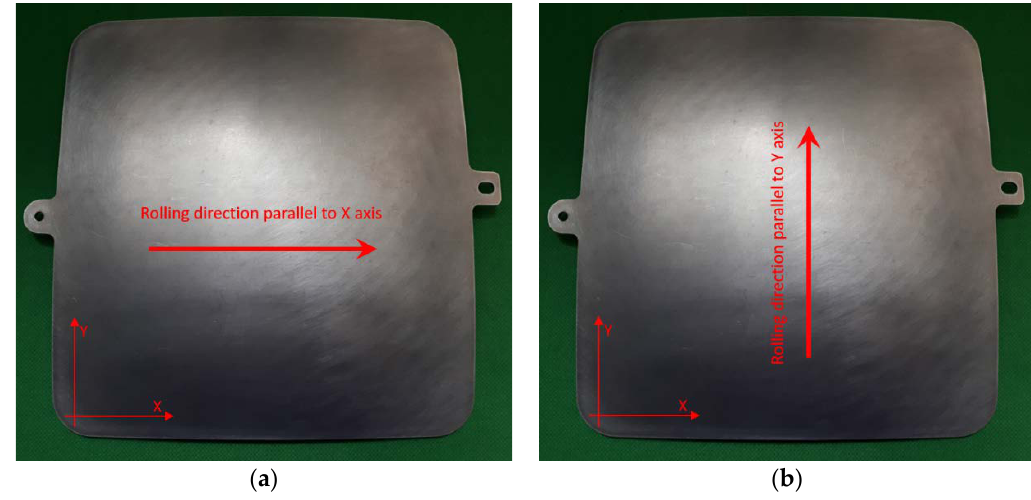
Figure 9. ( a ) Rolling direction of the simulations and real hydroformed sheet encoded as Part 1 (parallel to the X-axis); ( b ) rolling direction considered for the simulation of the hydroformed sheet (parallel to the Y-axis).